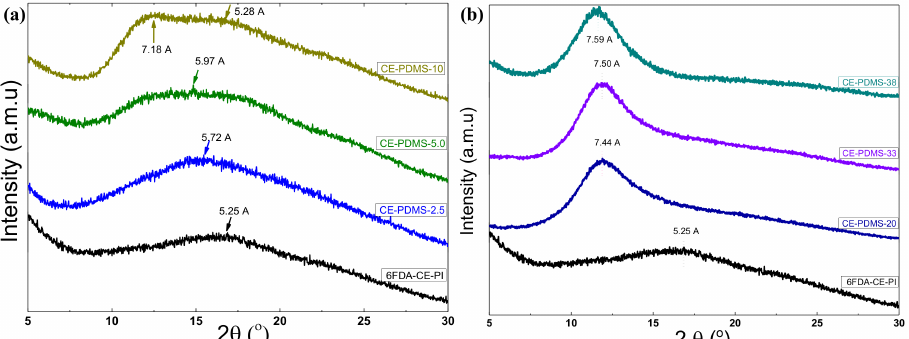
Figure 6. WAXD spectra of copolymer CE-PDMS-x membranes with different PDMS loadings ( a ) below the threshold value (2.5–10% loading) and ( b ) above the threshold value (20–38 wt %